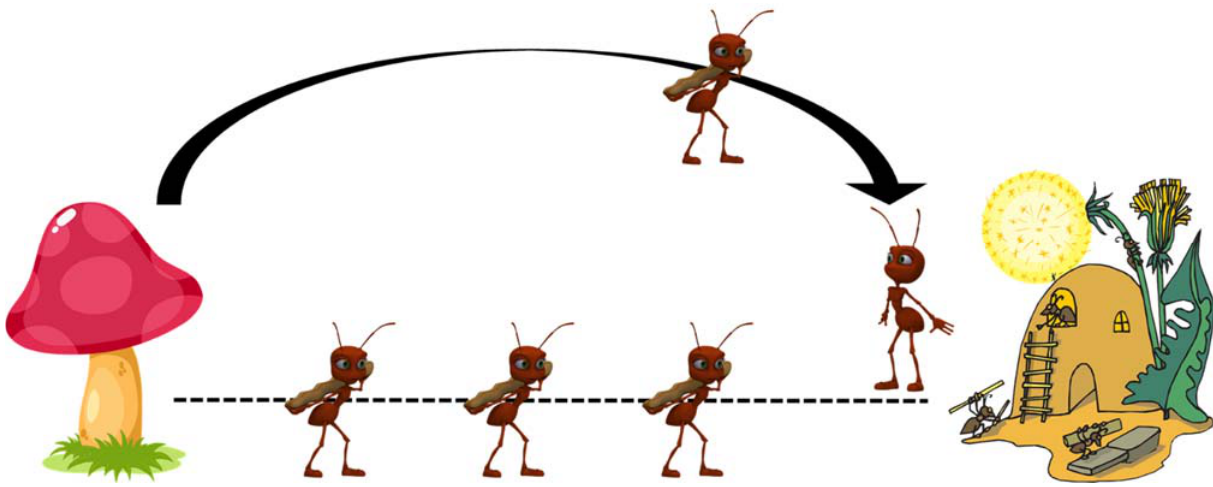
Figure 4. Ant Colony Optimization.